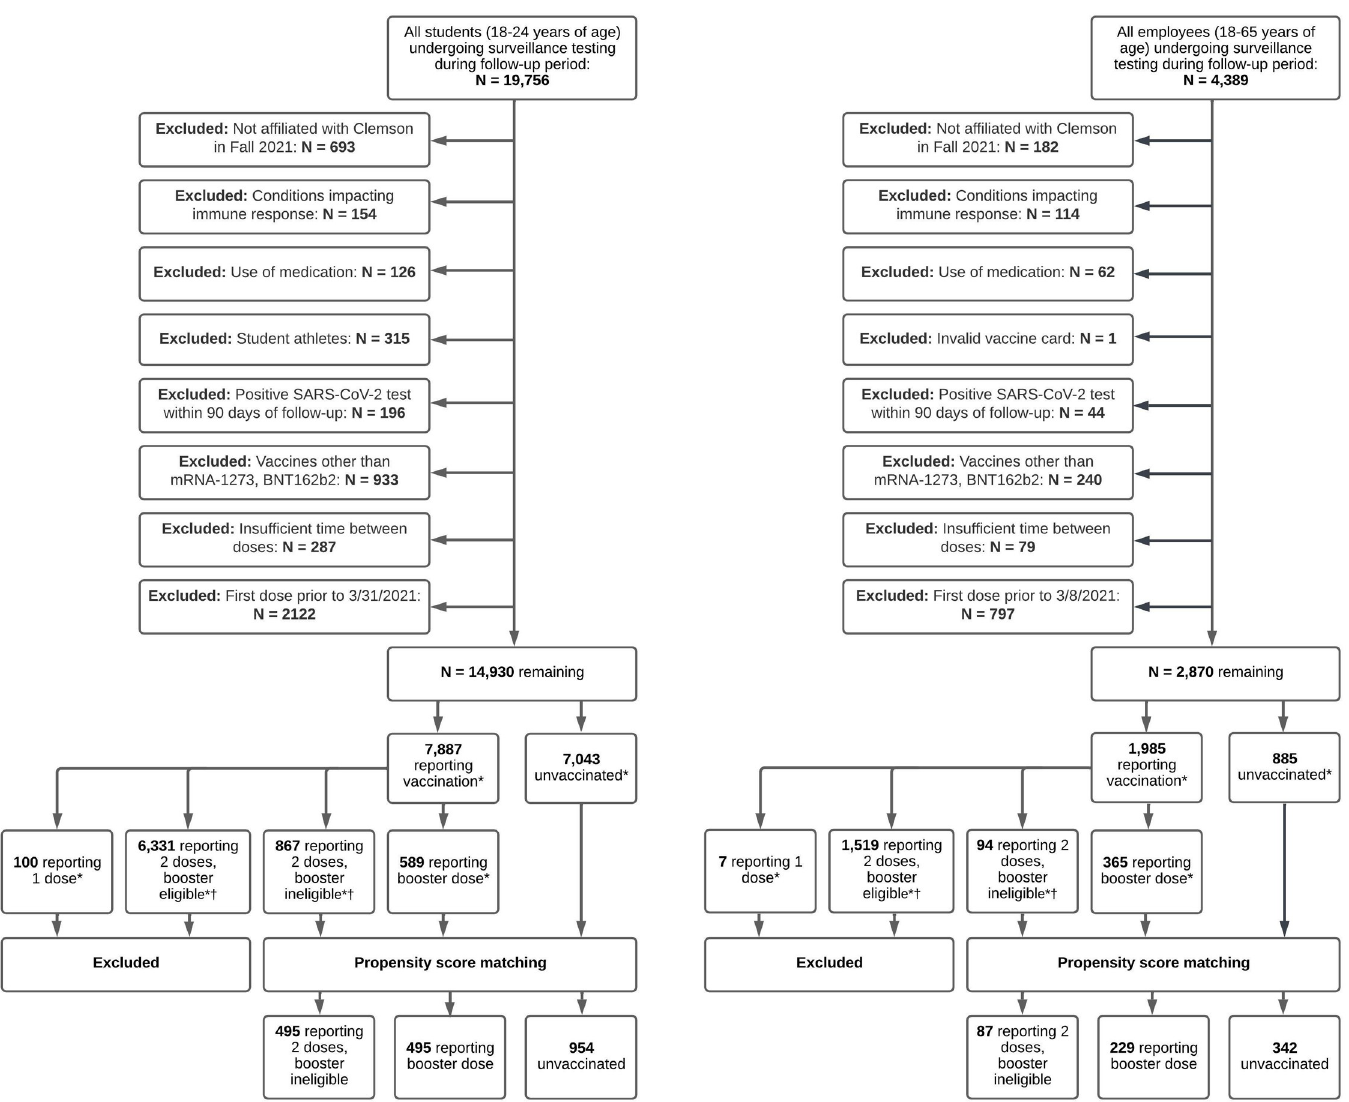
Fig 1. Flowchart of sample selection process for students and employees in main analysis during follow-up period between January 3 rd , 2022 and January 31 st , 2022. � By end of follow-up (Jan 31 st , 2022). † Booster eligible individuals are those receiving their 2 nd mRNA dose prior to August 24, 2021. The fully vaccinated, booster eligible cohort could consist of a mix of fully vaccinated individuals (completion of 2-dose mRNA series) and boosted individuals (completion of 3-dose mRNA series), and are therefore excluded. The fully vaccinated, booster ineligible cohort consists of individuals vaccinated within 5 months of end of follow-up (Jan 31 st , 2022) and were therefore not eligible to receive the booster